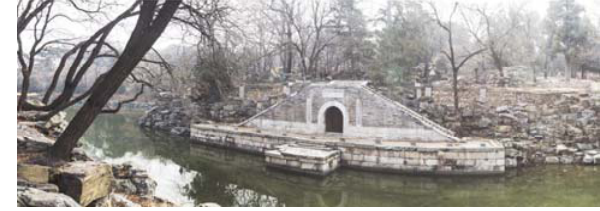
Figure.2 Current Situation of Qiwang Hall